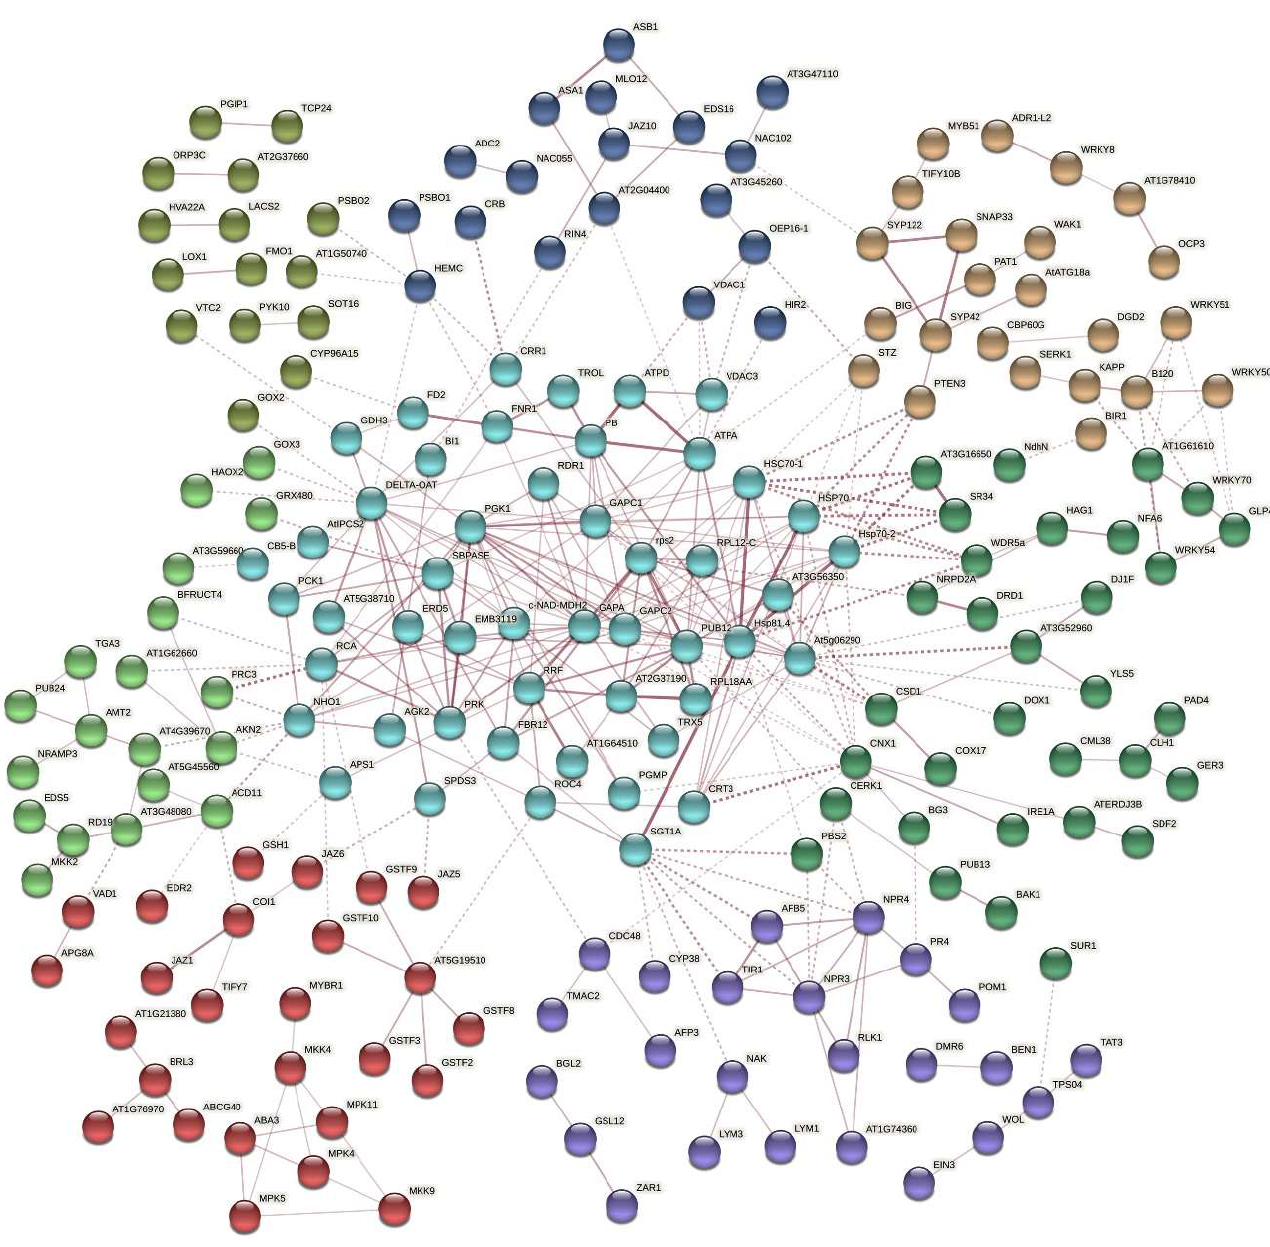
Figure 5. A network of protein–protein interactions based on Arabidopsis homologs of the DEGs. The image was produced on the STRING platform. The proteins are clustered and shown by their nodes in different colors. Thickness of edges indicates different confidence levels. Dotted lines are the edges between different clusters.